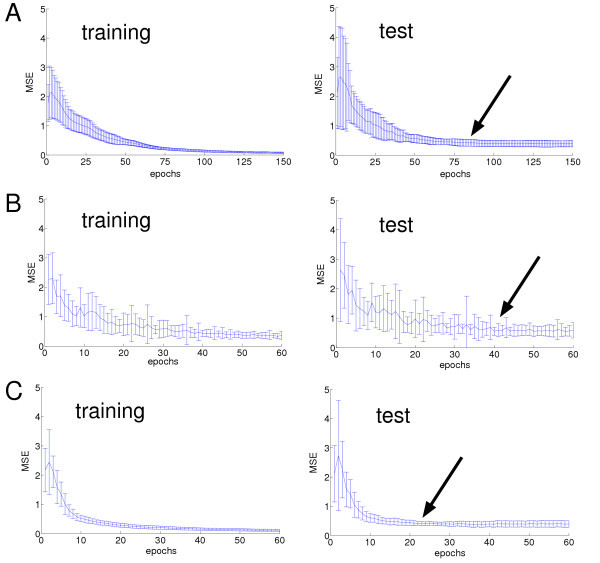
Mean MSE and standard deviation for net training of 20 neural nets with different PSO methods. A: standard PSO, B: CPSO, C: OPSO. Left: MSE for training data, right: MSE for test data. Arrows indicate approximate time of convergence.